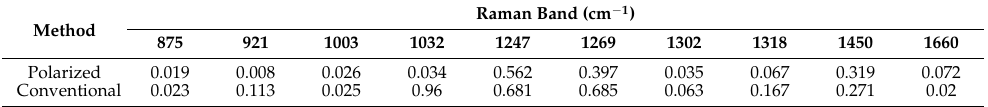
Table 2. Statistical differences ( p -values) of protein band intensities between normal and cancerous breast tissues collected with conventional and parallel PMRS, respectively.